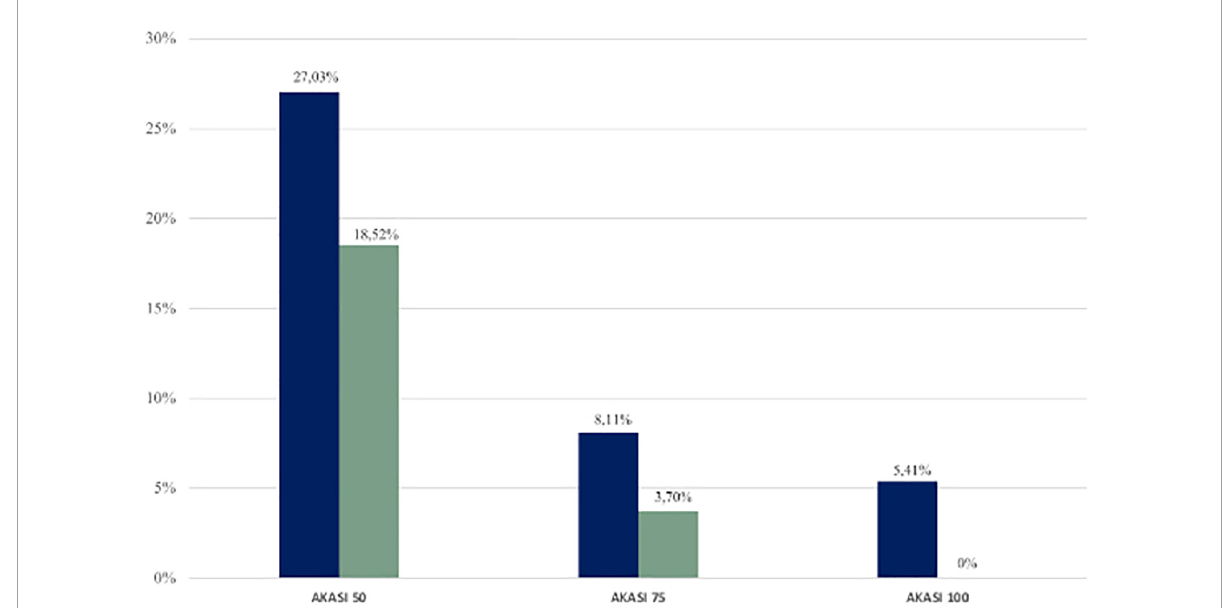
FIGURE3 Percentages of immunocompetent (blue) and immunosuppressed (green) patients who achieved AKASI 50, 75, and 100.